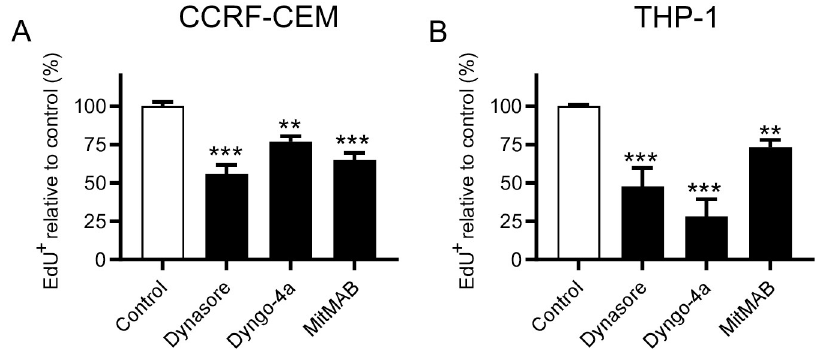
Fig 3. Dynamin inhibition reduces the proliferation of leukemia cells. 0.15 x 10 6 of CCRF-CEM (A) or THP-1 (B) cells/ml were cultured for 24 h (MitMAB) or 48 h (Dynasore and Dyngo-4a) with 40 μ M Dynasore, 10 μ M Dyngo-4a, or 2 μ M MitMAB (3 μ M for CCRF-CEM). EdU was added to a final concentration of 10 μ M 2 h prior to flow cytometry analysis. The proportion of proliferating (EdU + ) cells was normalized to untreated cells. The raw fraction of proliferating cells in CCRF-CEM was 52.64 ± 6.48% (mean ± standard deviation) and 40.56 ± 13.38% for THP-1. Data are given as mean + SEM, pooled from 6 biological replicates. One-way ANOVA was used for statistical testing with Dunnett’s posthoc test.